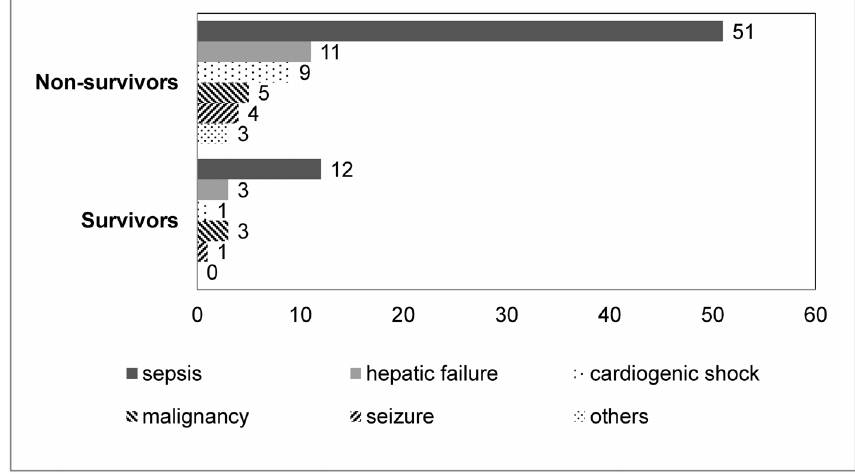
Figure 2. Causes of lactic acidosis and mortality.